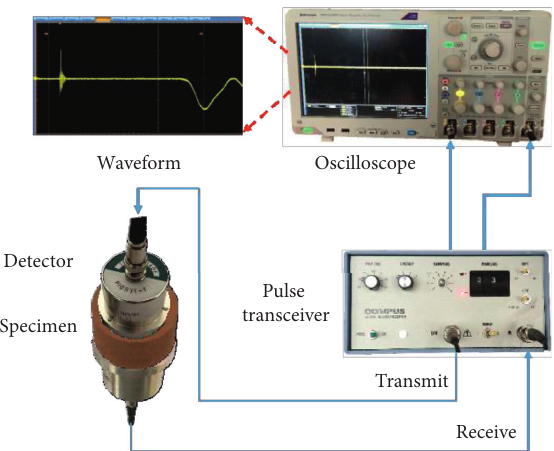
Figure 2: Longitudinal wave velocity test